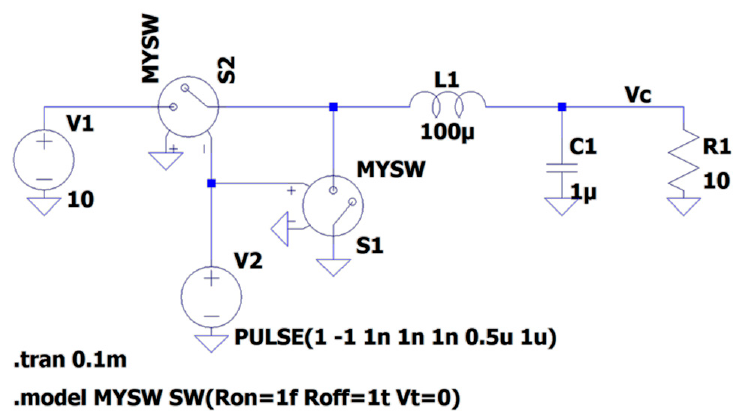
Figure A2. LTSPICE model of the buck power